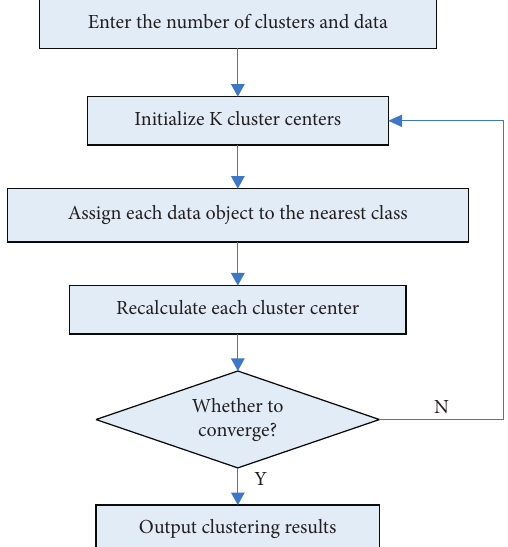
Figure 5: Schematic diagram of K-means clustering algorithm